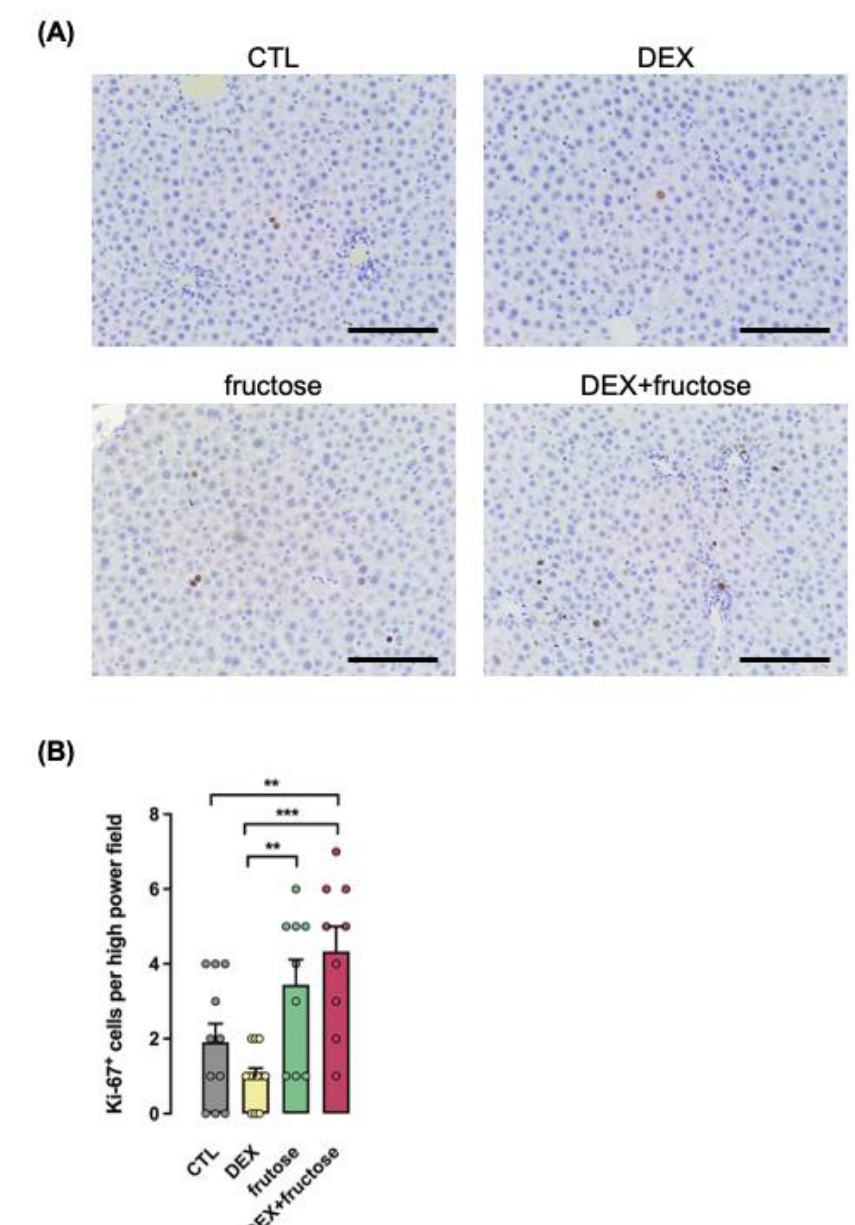
Figure 8. The proliferation marker Ki-67 is increased in the liver of rats born to DEX-treated mothers and that chronically consumed fructose in adult life. Representative images of liver sections used for immunohistochemical detection of Ki-67 ( A ). Average of Ki-67 positive cells (see Methods) are shown in ( B ). Data are presented as the mean ± SEM; ** p < 0.01 and *** p < 0.001 vs. the group indicated by the bracket. Horizontal bars = 10 μm. n = 9 to 11.